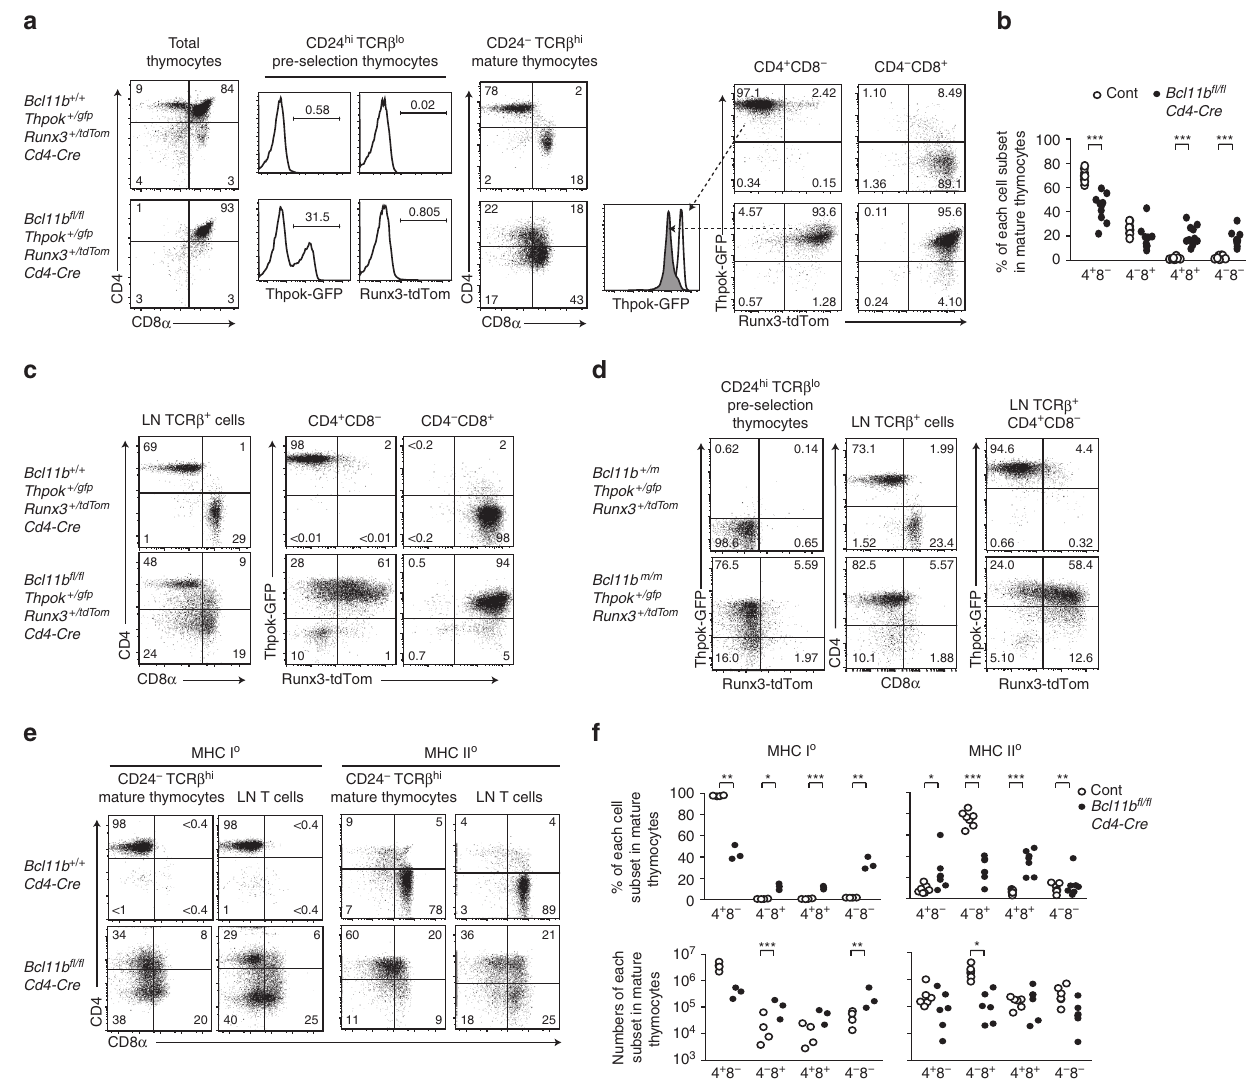
Fig. 4 Lineage scrambling resulting from inactivation of Bcl11b at the DP stage due to sporadic Thpok and Runx3 expression. a Flow cytometry analyzing the expression of CD4, CD8, Thpok-GFP, and Runx3-tdTomato by various thymocyte subsets in mice with the indicated genotypes. The histogram in the middle showing Thpok-GFP expression in CD4 + CD8 − mature thymocytes from control ( open ) and Bcl11b-de fi cient ( shaded ) cells. b Graph showing summary of percentage of each subset in mature (CD24 − TCR β hi ) thymocytes population of mice with indicated genotype. c Flow cytometry analyzing the expression of CD4, CD8, Thpok-GFP and Runx3-tdTomato in lymph node T cells of mice with the indicated genotypes. One representative of at least independent mice. d Flow cytometry analyzing the expression of CD4, CD8, Thpok-GFP and Runx3-tdTomato in pre-selection DP thymocytes and lymph node T cells differentiated in Rag1-KO hosts from Bcl11b + / + and Bcl11b m/m fetal livers harboring Thpok gfp and Runx3 tdTomato reporter alleles. One representative of two independent experiments. e , f Representative fl ow cytometry e analyzing differentiation of MHC-I and MHC-II selected cells in MHC-II and MHC-I de fi cient (MHC-II 0 and MHC-I 0 ) backgrounds, respectively, along with a graph f showing a statistical summary of the percentages and absolute numbers in each cell subset in CD24 − TCR β hi mature thymocytes population of control (white circles) and Bcl11b fl / fl :Cd4-Cre ( fi lled circles) mice. Partial re-directed differentiation occurred in both MHC-I and -II selected cells. * P < 0.05, ** P < 0.01, and *** P < 0.001(unpaired t